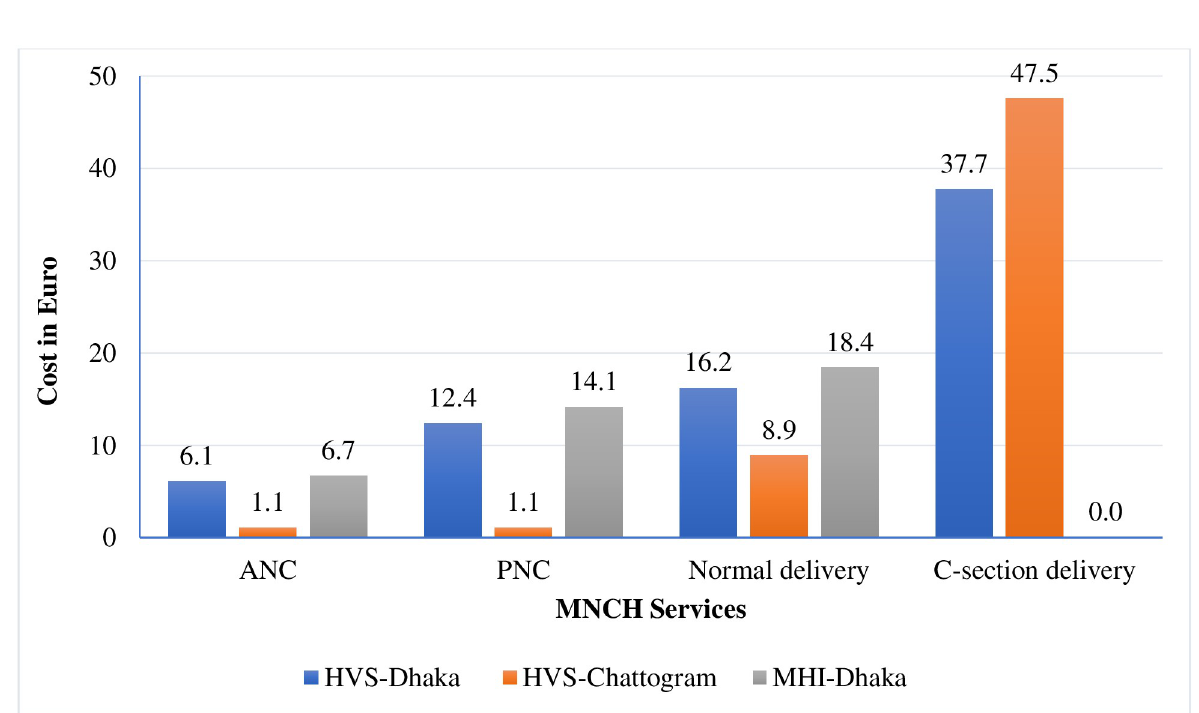
Fig 4. Out of pocket for MNCH services (six months prior to survey).